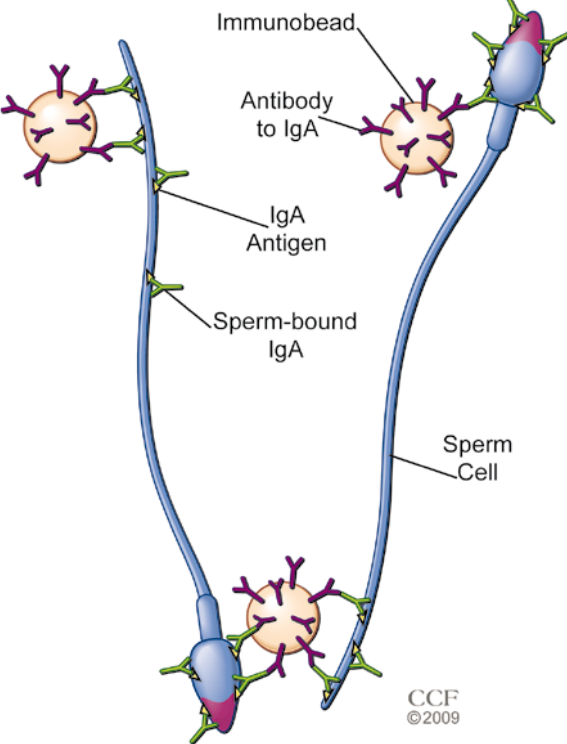
Figure 2 - Immunobead test. Spermatozoa are mixed with beads that have been coated with IgG class-specific secon- dary antibodies. Reprinted from Int J Urol. 2010; 17: 839-47. Samplaski, et al. New generation of diagnostic tests for in- fertility: review of specialized semen tests, with permission from publisher (John Wiley and Sons)